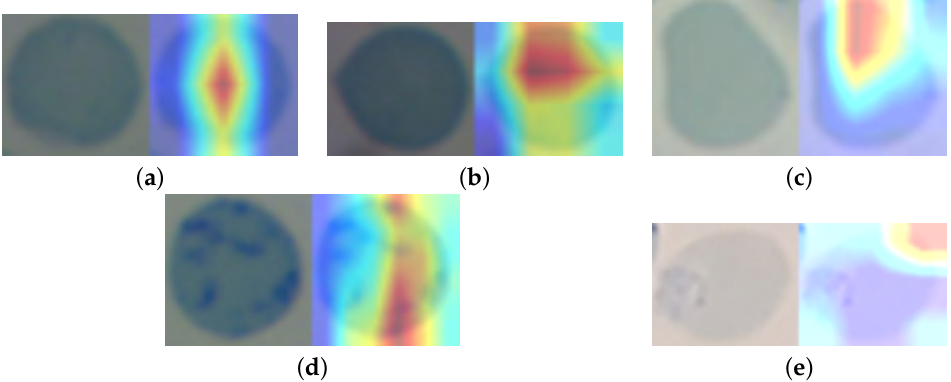
Figure 12. Sample heatmaps for the feline reticulocyte dataset. ( a ) Densenet HeatMap. ( b ) Mo- bileNet HeatMap. ( c ) ResNet HeatMap. ( d ) VGG HeatMap. ( e ) Xception